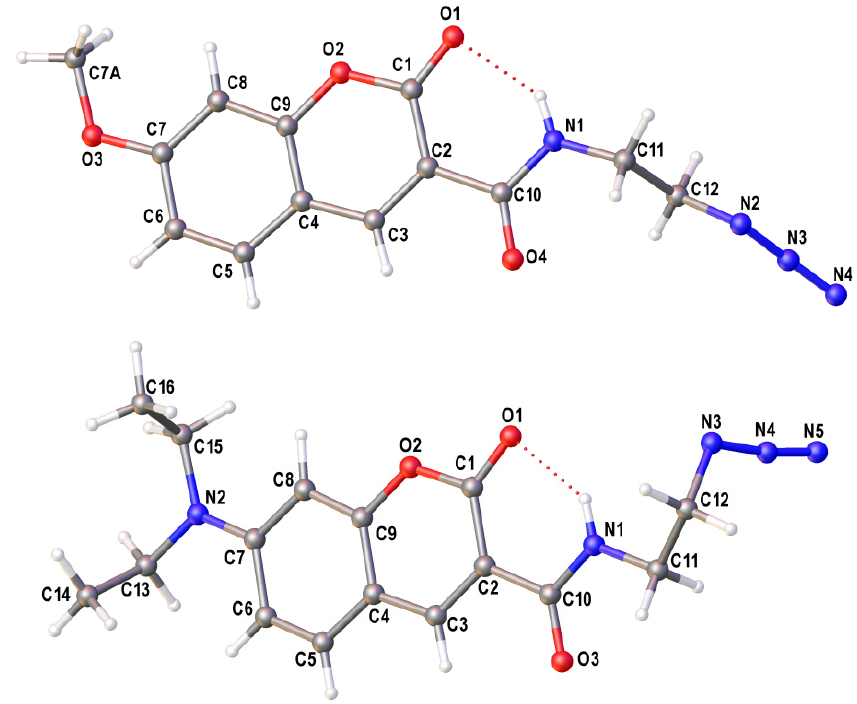
Figure 2. Molecular crystal structures of 2a (top) and 2b (bottom). Non ‐ hydrogen atoms are pre ‐ sented by probability ellipsoids of atomic displacements ( p = 0.5). Dotted lines correspond to the intramolecular hydrogen bonds.